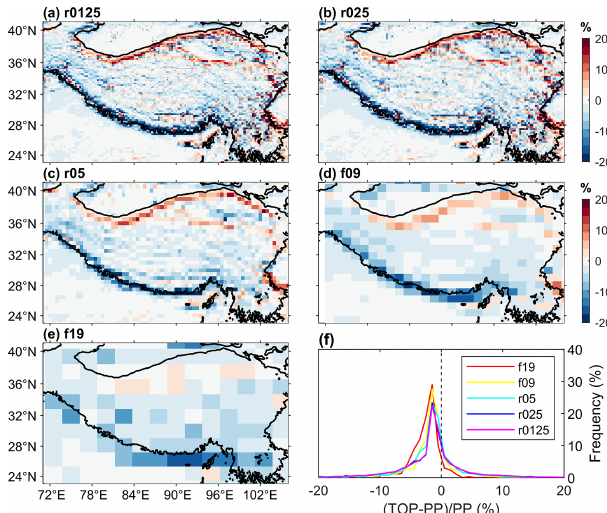
Figure 8. The relative differences of land surface albedo between TOP and PP in winter at different spatial scales (a–e) and the statis- tical histogram of their frequent distributions (f)